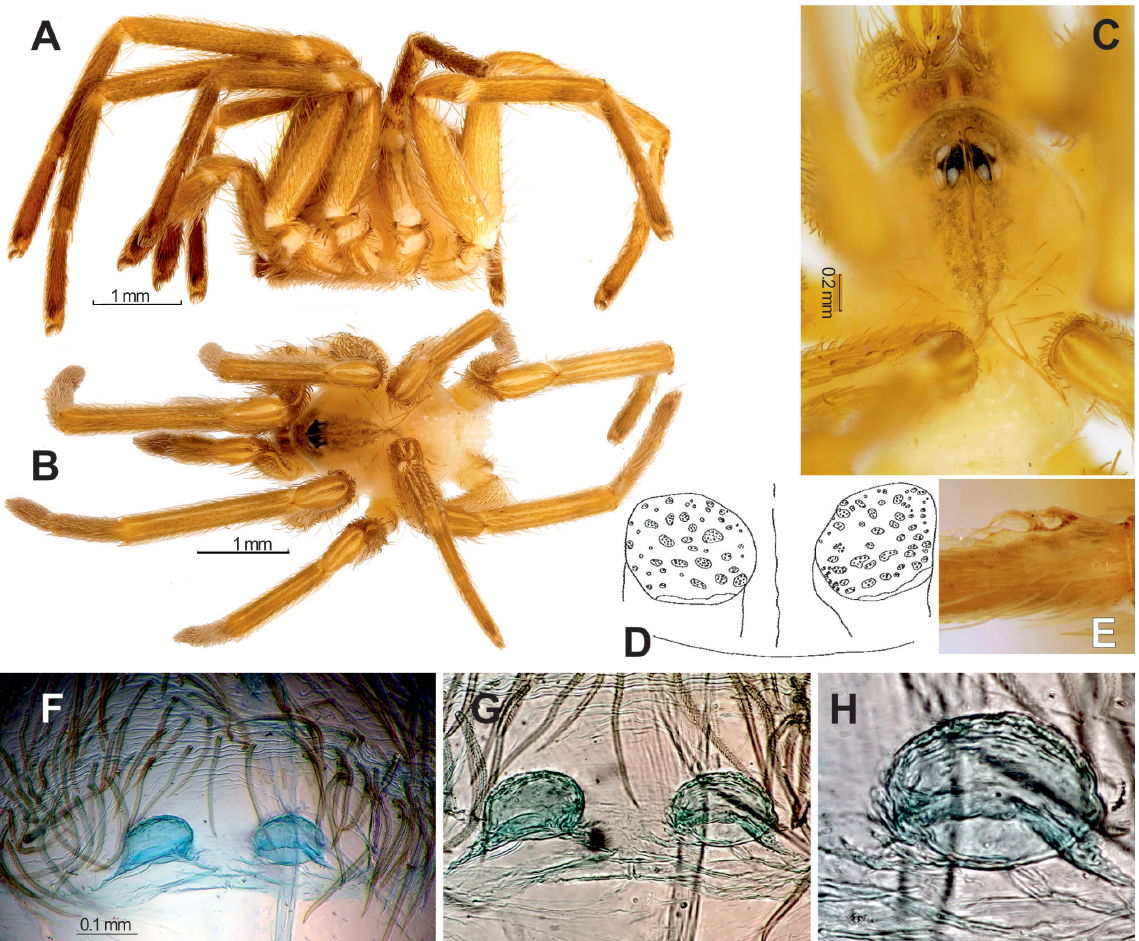
Fig. 17. Somatic characters and endogyne of Zaitunia medica Brignoli, 1982, holotype, ♀. A. Prosoma, lateral. B–C . Prosoma, dorsal. D , F–G . Endogyne, dorsal (D: after Brignoli 1982). E . Calamistrum, dorsal. H . right receptacle, dorsal. Scale bars: a, B = 1.0 mm; C = 0.2 mm; F = 0.1